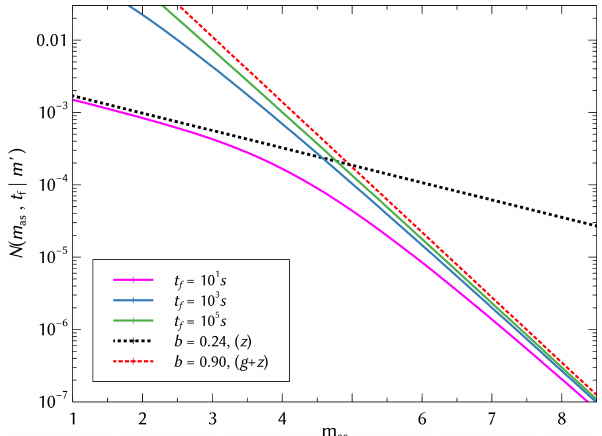
Figure 1. Plot of Eq. (7) for m (cid:48) = 1 . 8 and t f = 10 1 , 10 3 and 10 5 s. Dashed lines correspond to the b value exponent; b = z for early times (black), and b = g + z for late times